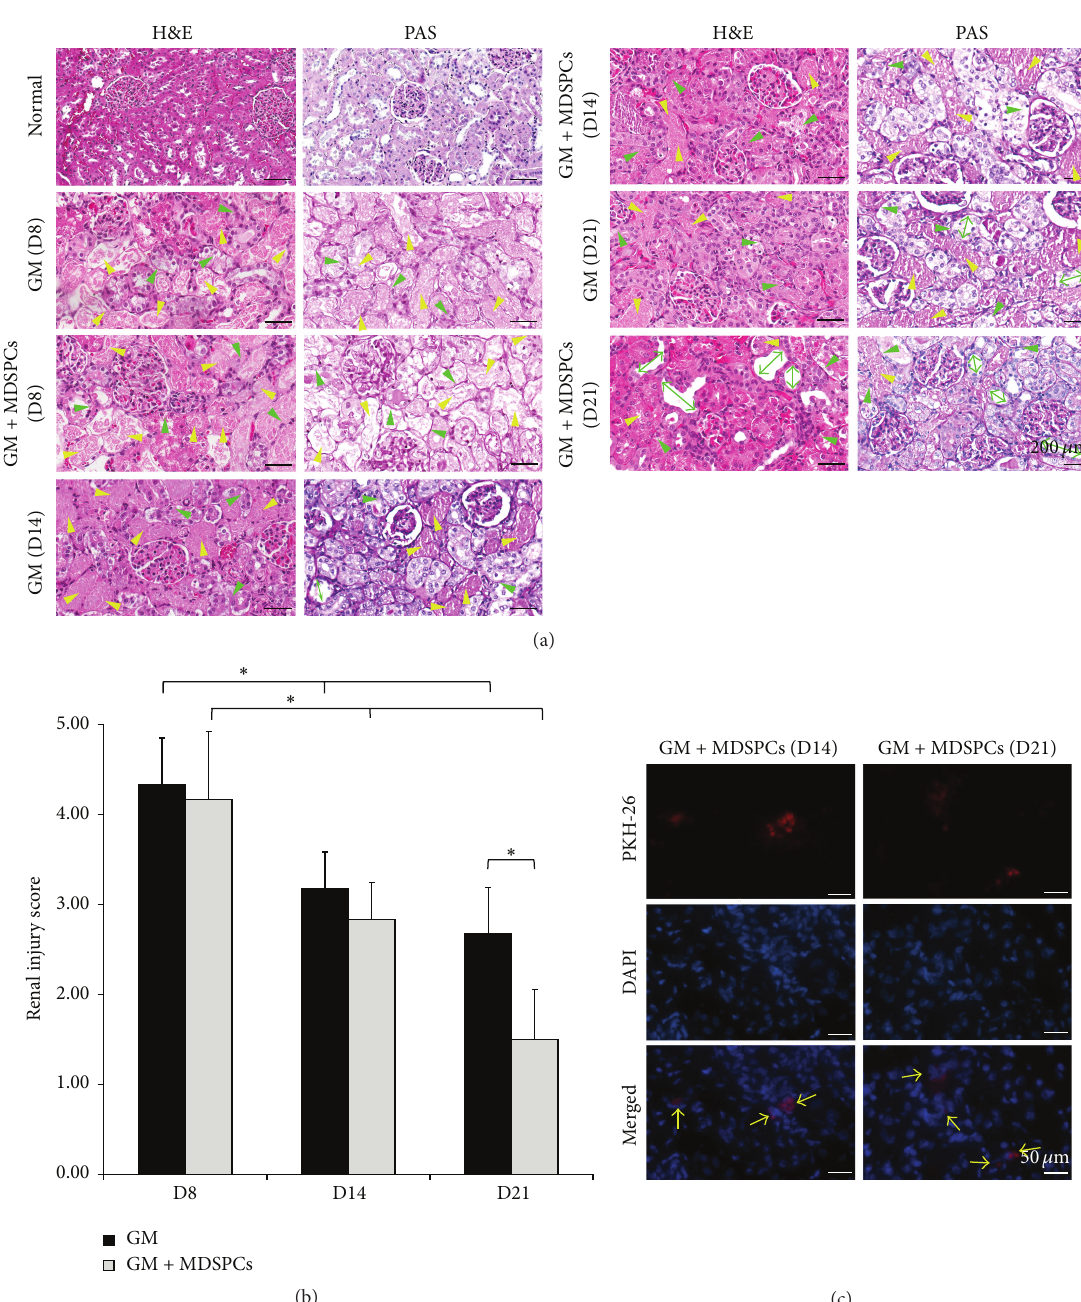
Figure 6: MDSPCs impact on morphological recovery after AKI and their presence in the damaged renal tissue during the period of 2 weeks. Gentamicin injections at 80mg/kg for 7 consecutive days caused typical aminoglycoside-induced AKI, including the tubular necrosis (yellow arrow heads), loss of brush border in renal tubules (green arrow heads), and tubular dilatation (green both-way arrows) ((a); GM (D8) and GM + MDSPCs (D8)), represented by the renal injury score of 4.33 ± 0.52 and 4.17 ± 0.75 , respectively (b). MDSPCs injection attenuated renal tubular damage ((a); GM + MDSPCs (D21)) and significantly lowered renal injury score to 1.5±0.55 , compared with the injury score of 2.67 ± 0.52 in GM group after 21 days ((b); 𝑝 = 0.008 ). PKH-26-labeled MDSPCs were detected within the renal cortex, localized primarily in the renal tubules and the interstitial compartment of the kidney 7 and 14 days after the MDSPCs administration ((c); yellow arrows). ∗ 𝑝 < 0.05 , significant